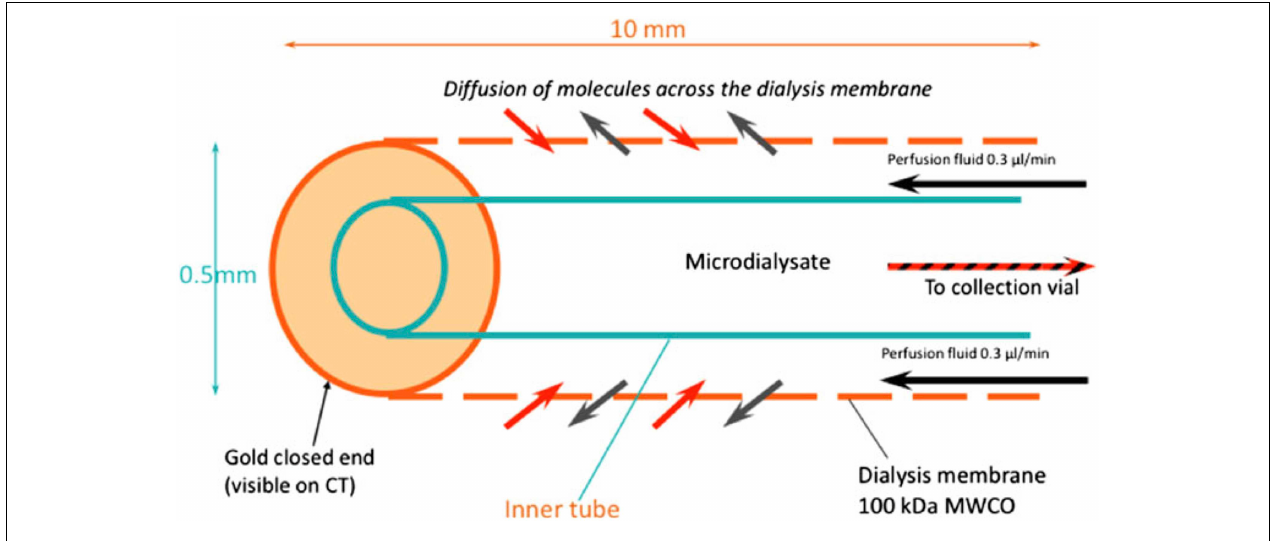
FIGURE 1 | Schematic of the microdialysis catheter tip. Substances in the extracellular fluid outside the catheter tip are able to diffuse across the microdialysis membrane to be collected for analysis. Abbreviation: